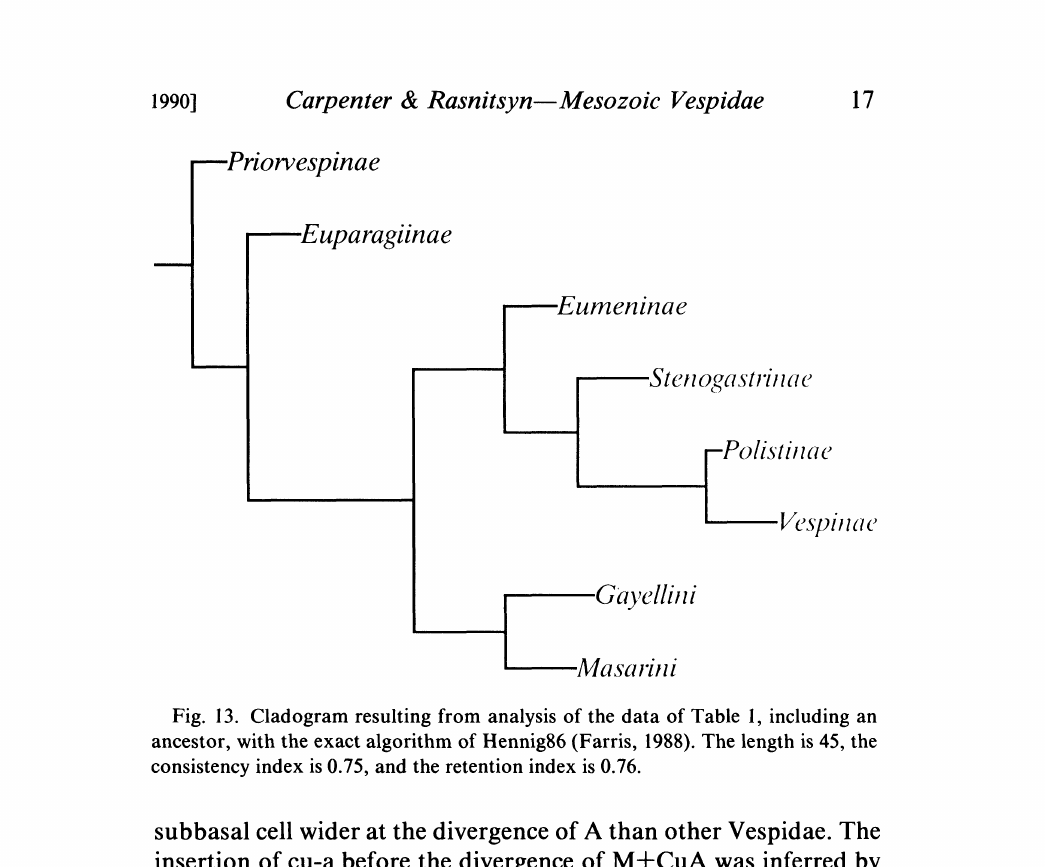
Fig. 13. Cladogram resulting from analysis of the data of Table 1, including an ancestor, with the exact algorithm of Hennig86 (Farris, 1988). The length is 45, the consistency index is 0.75, and the retention index is